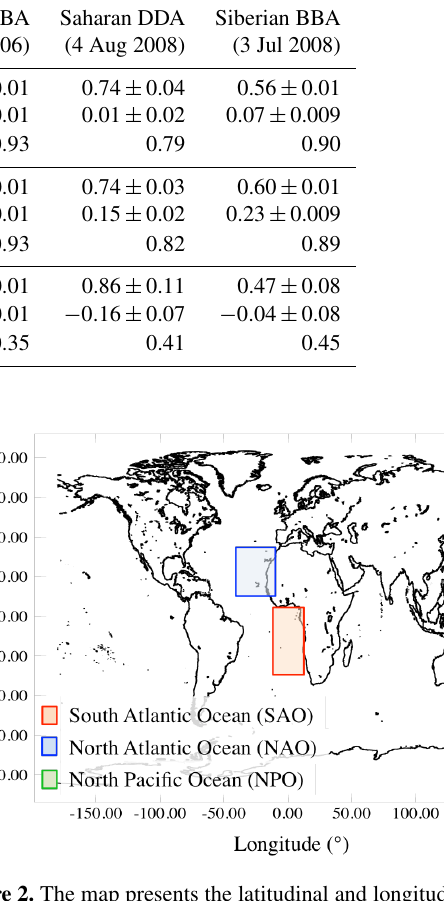
Figure 2. The map presents the latitudinal and longitudinal bound- aries of the three regions used in the regional study (Sect. 3): South Atlantic Ocean (SAO) extends from 30 ◦ S to 5 ◦ N and 12 ◦ W to 14 ◦ E, North Atlantic Ocean (NAO) is situated between 10 and 35 ◦ N and 10 and 40 ◦ W and North Pacific Ocean (NPO) is located between 35 and 60 ◦ N and 140 and 170 ◦